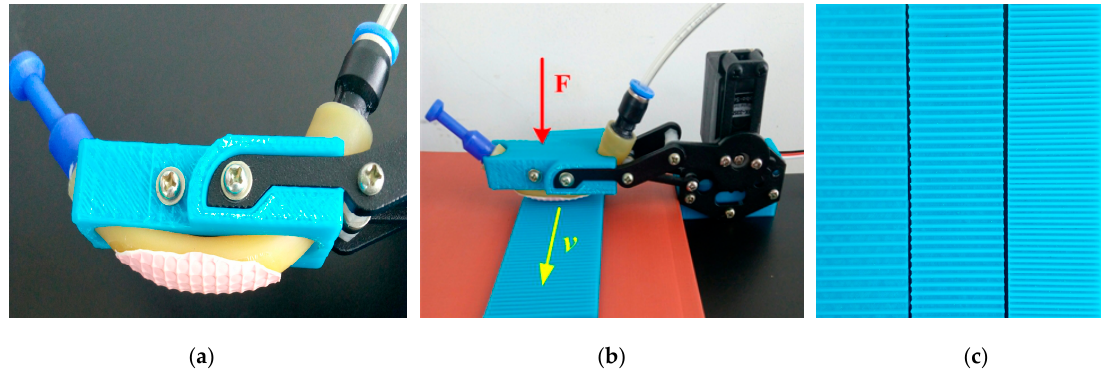
Figure 7. The experiment of sensing the surface of object. ( a ) a fingertip with the fingerprint; ( b ) the relative movement between the fingertip and the test surface; ( c ) the test grooves.